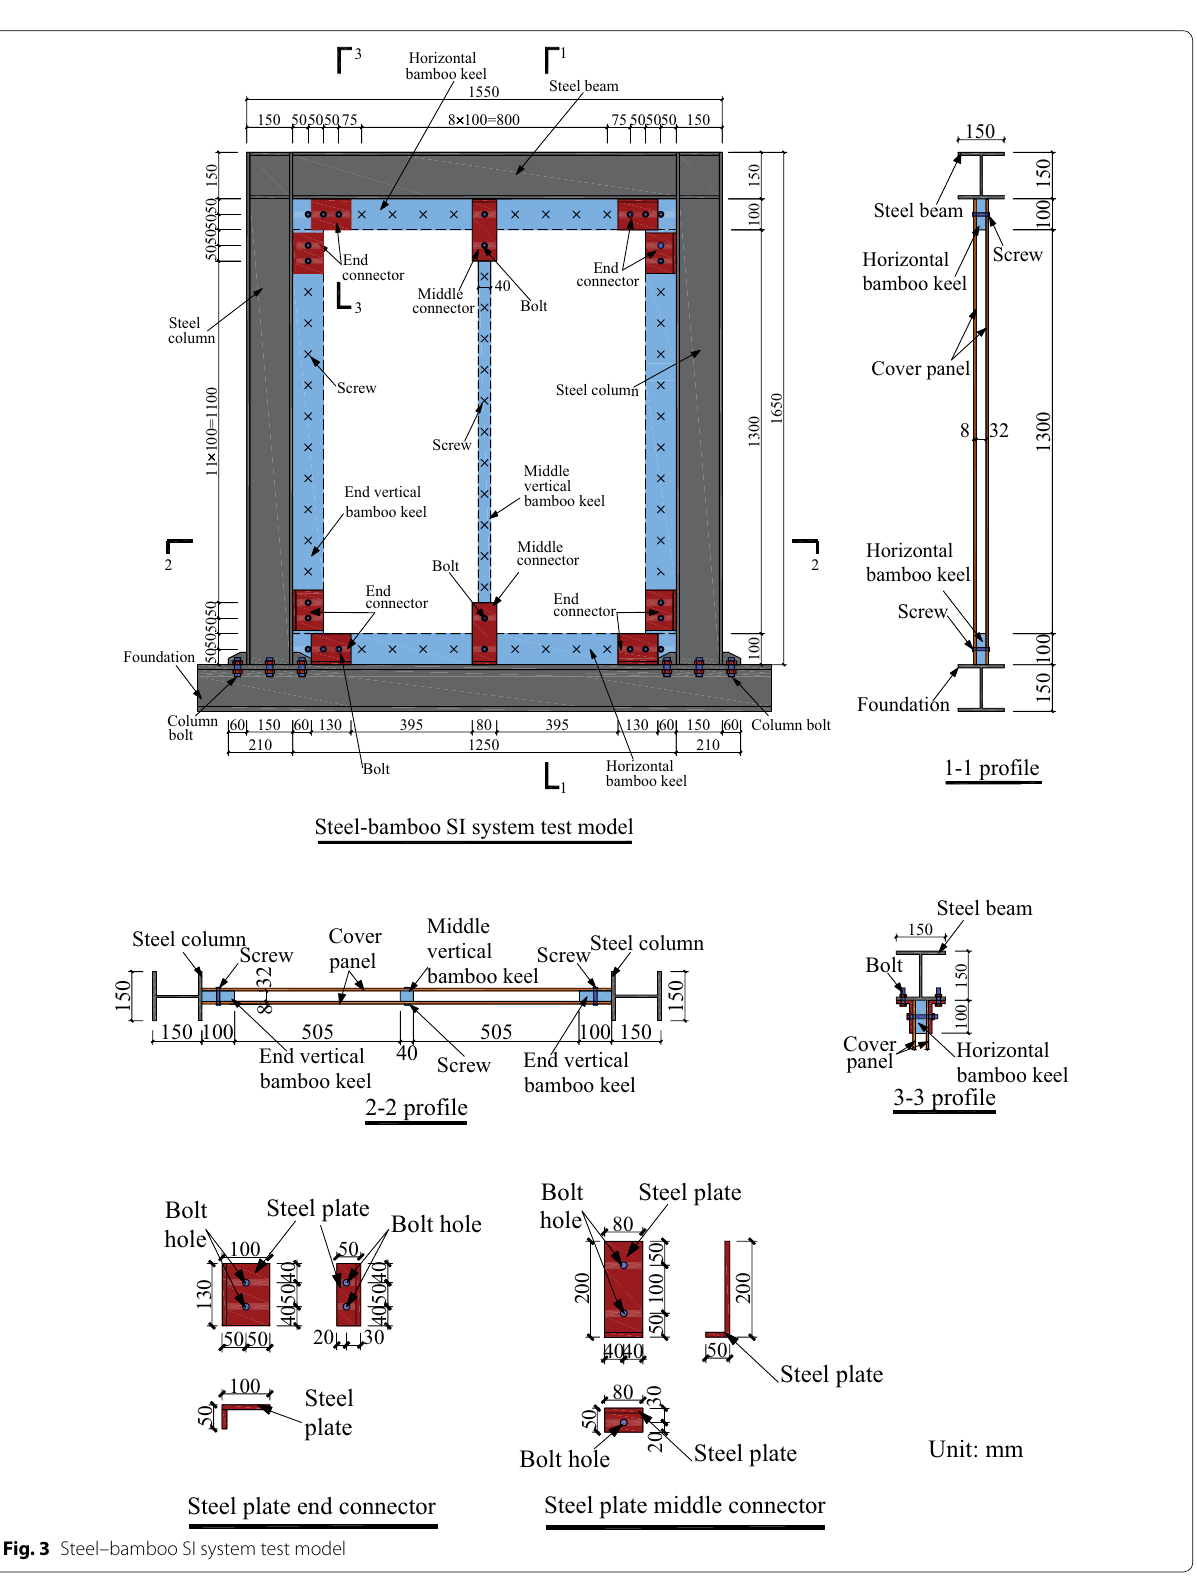
Fig. 3 Steel–bamboo SI system test